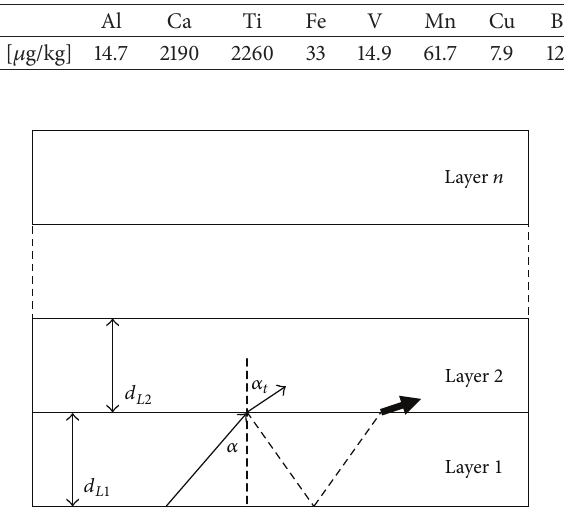
Figure 2: An unaltered sedimentary structure of a salt dome [23]. The solid thin lines represent waves that propagate in each layer. The dashed lines show the reflected ones. The thick solid line shows the wave that enters in a layer after multiple reflections. The thickness of layer 𝑖 is 𝑑 𝐿𝑖